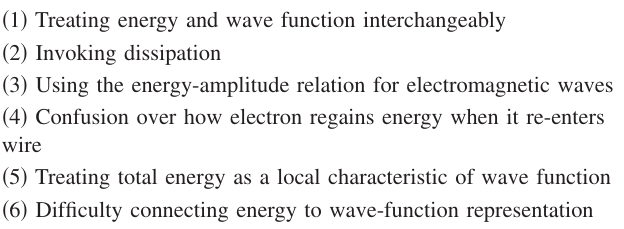
TABLE I. Reasons students may think that energy is lost